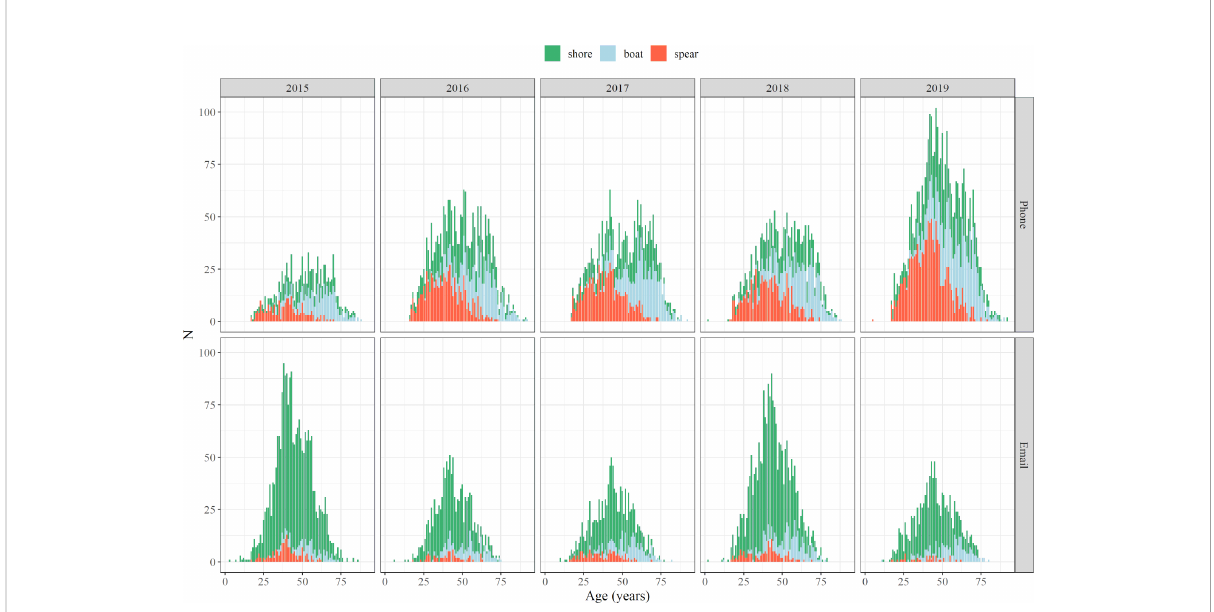
FIGURE 3 Age distribution of fi shers that provided information on phone and email surveys from 2015 to 2019, for each of the fi shing modes (shore fi shing, boat fi shing, spear fi